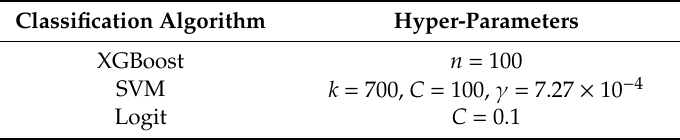
Table A2. Hyper-parameter selected for the model used under the BRIR matched test conditions.